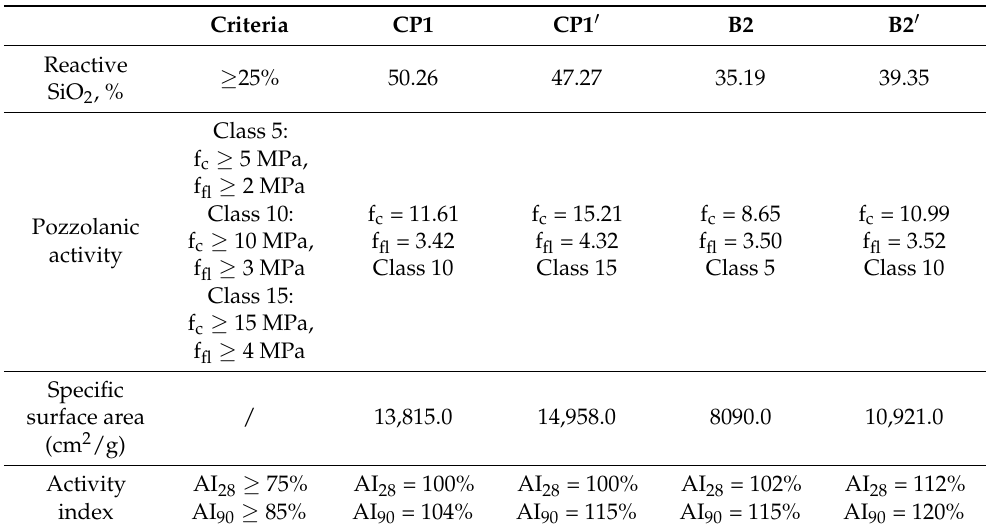
Table 6. Chemical, physical and pozzolanic properties of selected ceramic powder and biomass